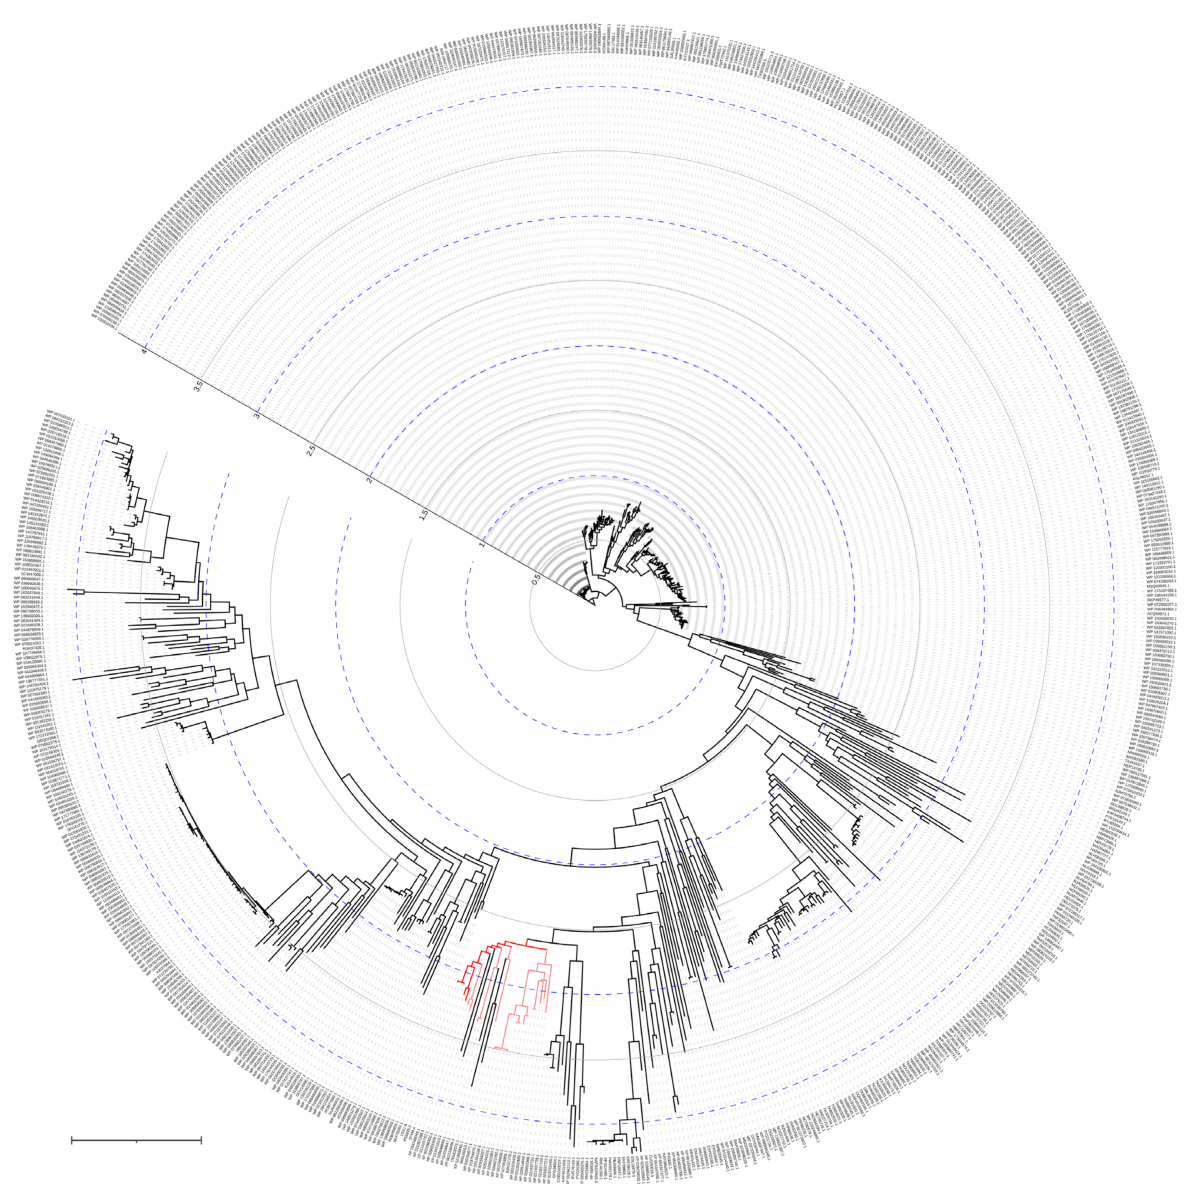
Figure 22. Phylogenetic tree of PEPP and its homologous enzymes (down to 64% identity). The tree was built as previously with PDB 1S2V as a reference sequence. Enzymes having high (90–100%) and good (80–89%) identity are highlighted with red and pink,